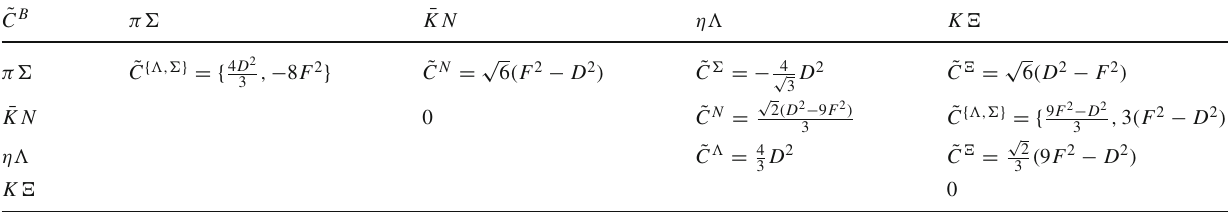
Table 3 Coefficients ˜ C B of the crossed-Born terms in the strangeness S = − 1 sector with isospin I = M j B j , M i B i